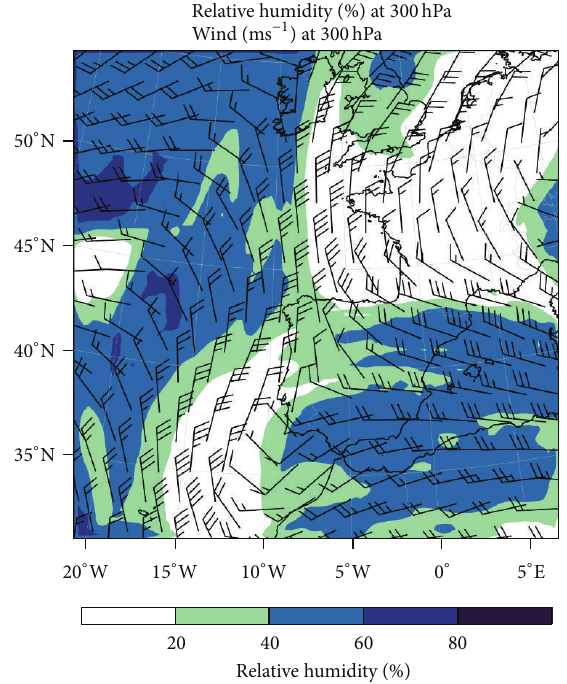
Figure 9: Relative humidity and wind at 300 hPa modeled by WRF in domain